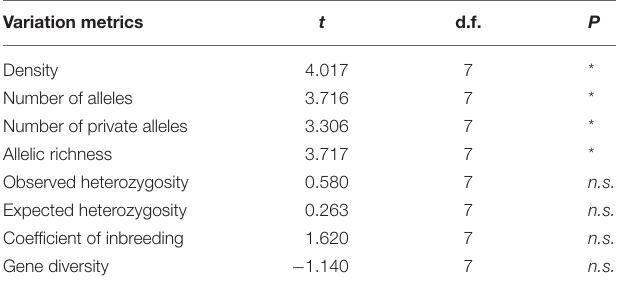
TABLE 3 | Summary of t- test for density and genetic variation metrics of Amphiprion ocellaris between Barrang Lompo and Samalona (* < 0.05, n.s., not significant).